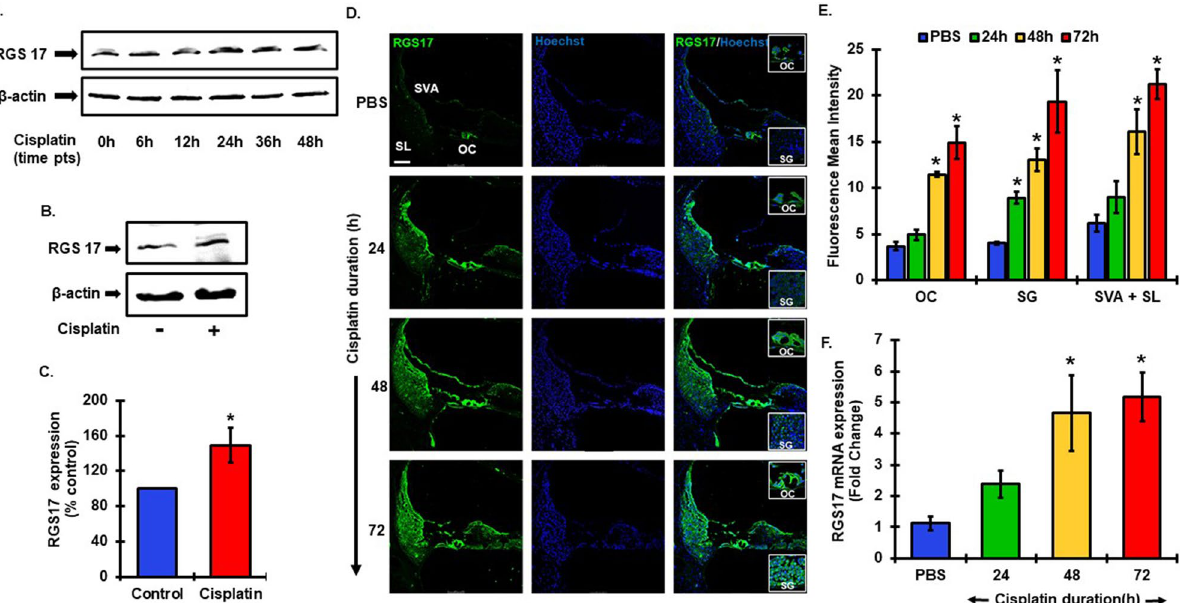
Figure 2. Cisplatin administration increased RGS17 expression and protein levels in both in vitro and in vivo models. ( A ) UB/OC1 cells were treated with cisplatin (20 μM) for 6, 12, 24, 36 and 48 h. Cell lysates were prepared for western blot analysis which showed increase in RGS17 expression post cisplatin treatment. ( B ) Western blotting result showed increased protein level expression of RGS17 after 24 h of cisplatin (20 μM) treatment. ( C ) Graphical representation of western blot analysis from ( B ) showing RGS17 expression significantly increased after 24 h of cisplatin treatment. Data represents mean ± SEM, *p < 0.05, N = 4, independent t-test. ( D ) Male Wistar rats were treated with cisplatin (11 mg/kg, i.p) or sterile PBS (1 ml, i.p) for 24 h, 48 h and 72 h. Cochleae from treated animals were fixed with 4% PFA and processed for mid-modiolar sections. Cochlear sections were immunolabeled with RGS17 (green) and Hoechst (blue). Cisplatin treated animals showed notably higher level of fluorescence indicating increased the levels of RGS17 as compared to PBS treated animals at 24, 48 and 72 h post treatment. ( E ) Bar graph representing the mean fluorescence intensity of RGS17 immunostaining (refer ( D )) in different region of the cochlea: OC, SG and lateral wall (SL + SVA). Data represents mean ± SEM, *p < 0.05, N = 4, two-way anova. ( F ) Cochleae were also collected for RNA extraction for RT-qPCR analysis. Cisplatin treatment increased RGS17 l expression at all time points tested and it was significantly elevated at 48 h and 72 h. Data indicate mean fold change in the mRNA levels ± SEM, N ≥ 3, *p < 0.01 vs. PBS, one-way